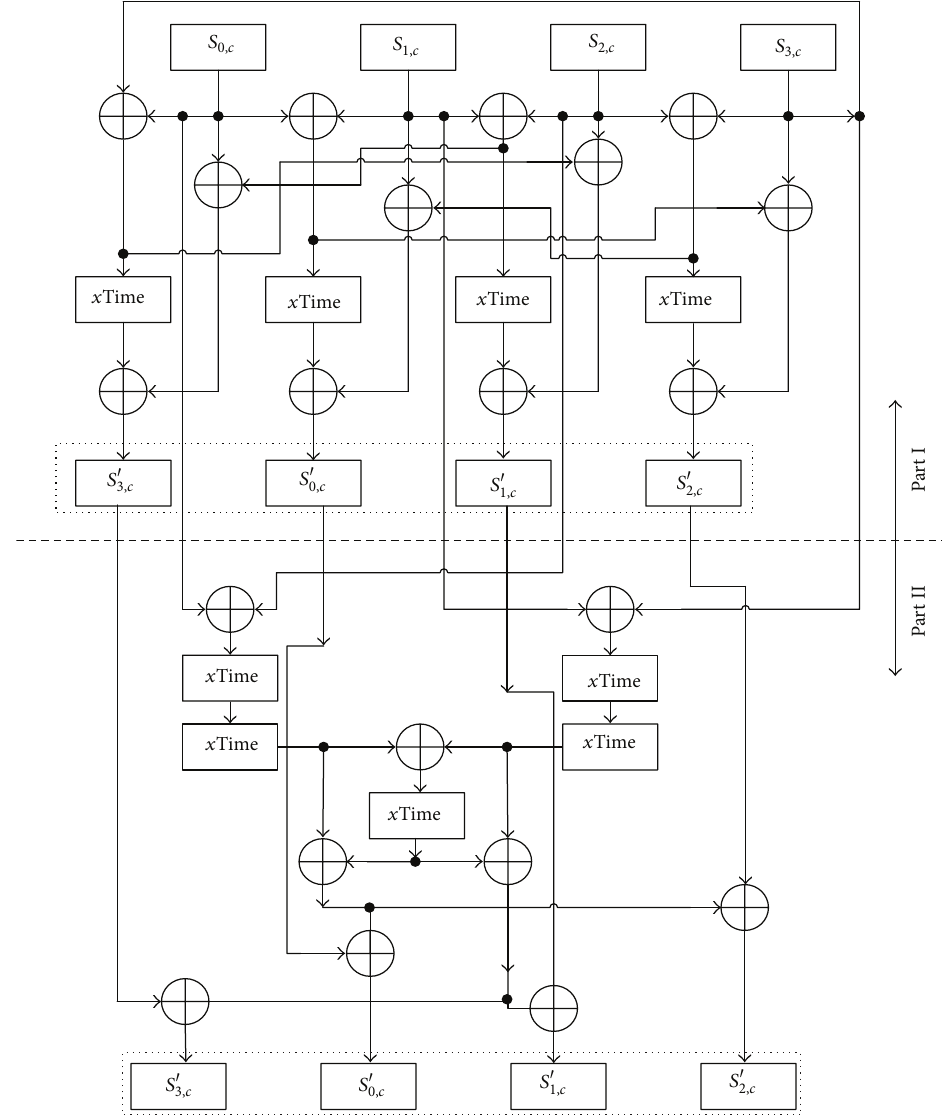
Figure 18: The MixColumns transformation process using the xTime circuit.